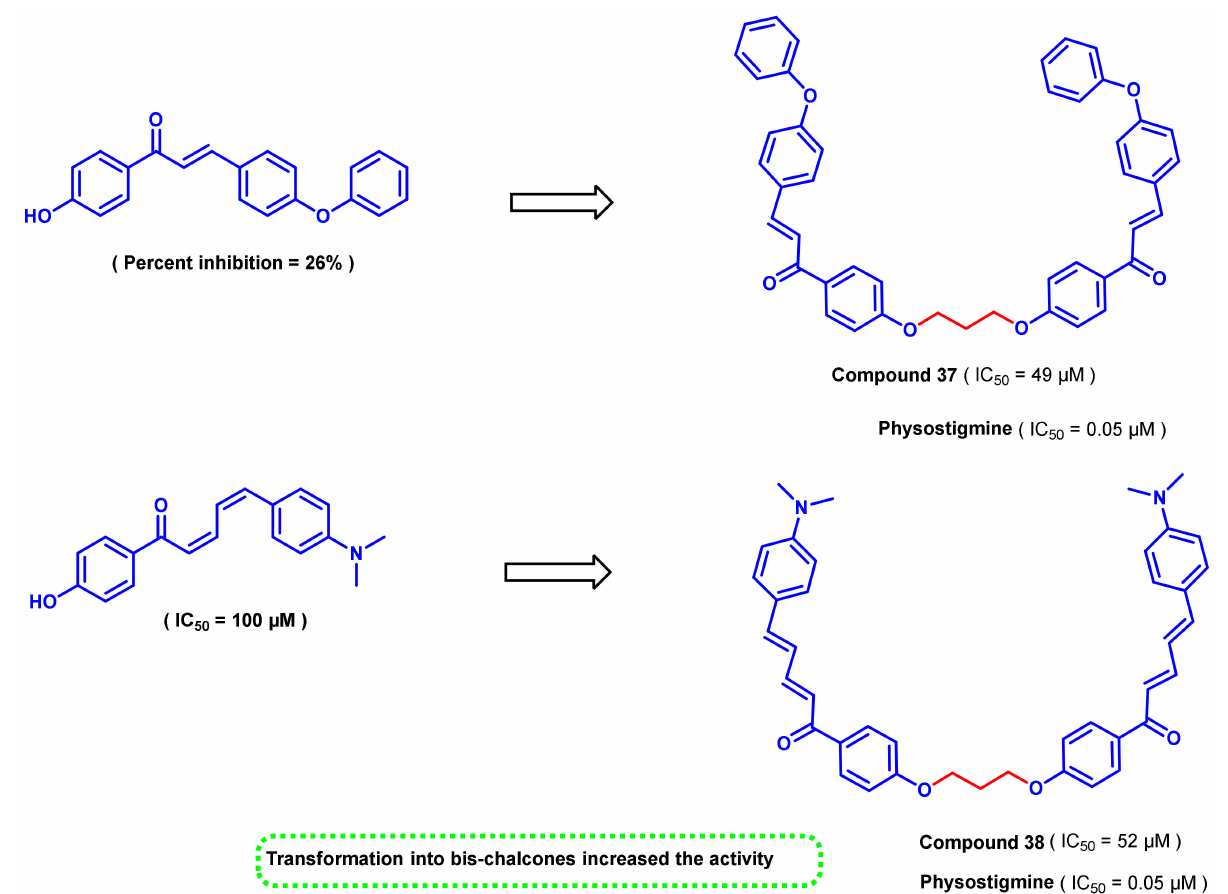
Figure 35. Chemical structures of 4-hydroxy chalcones and bis-chalcone